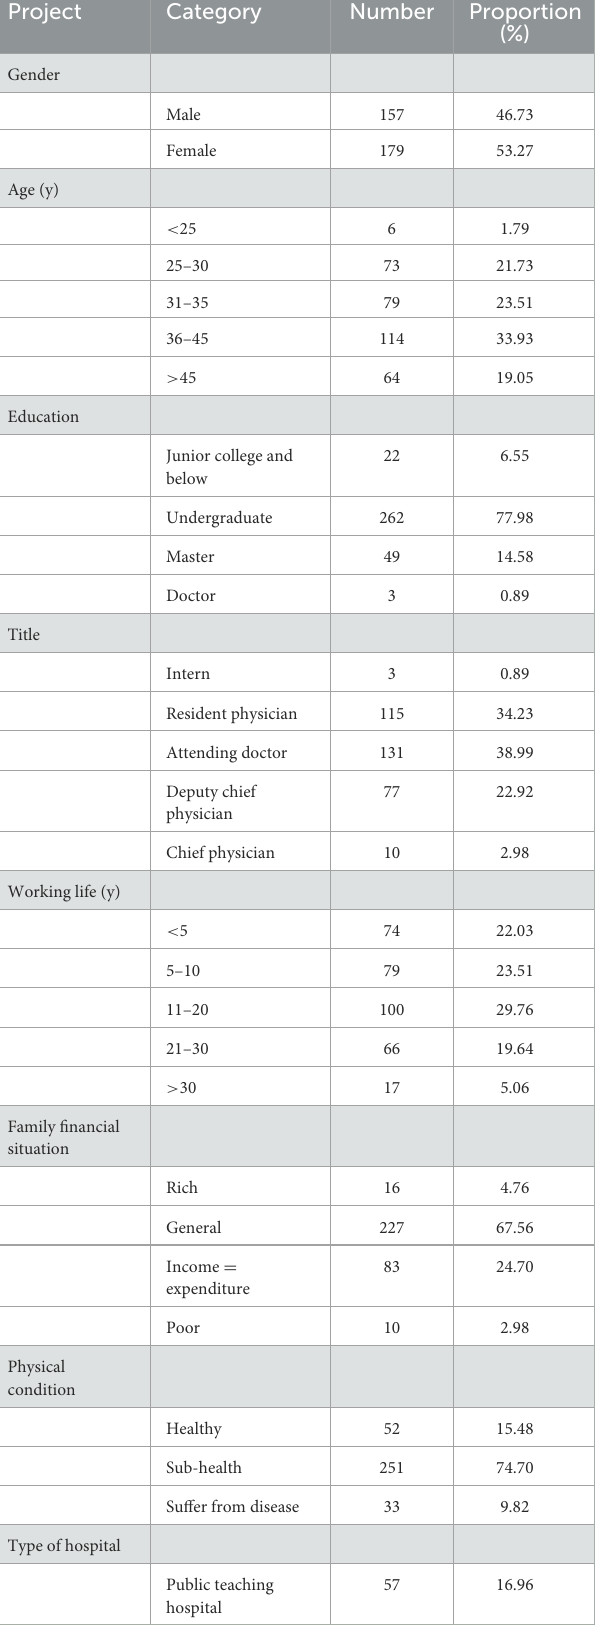
TABLE 1 Descriptive statistics of the survey ( n =